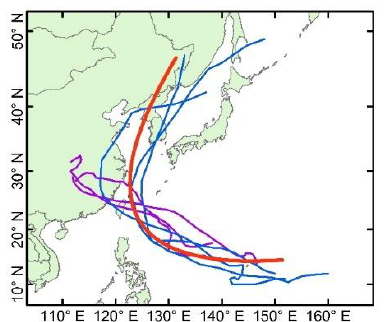
Figure 9. Quadratic polynomial fitting result of the TC trajectories.